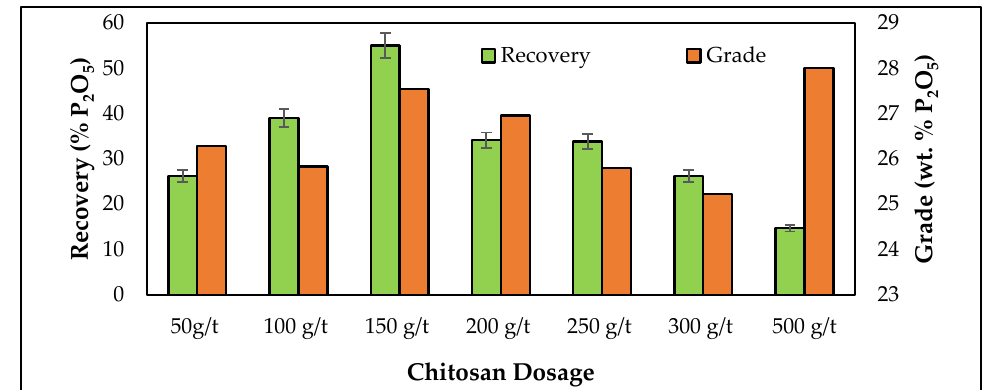
Figure 6. Recoveries and grades of P 2 O 5 in the flotation concentrates when chitosan was used as a depressant at different dosages and pH 7.